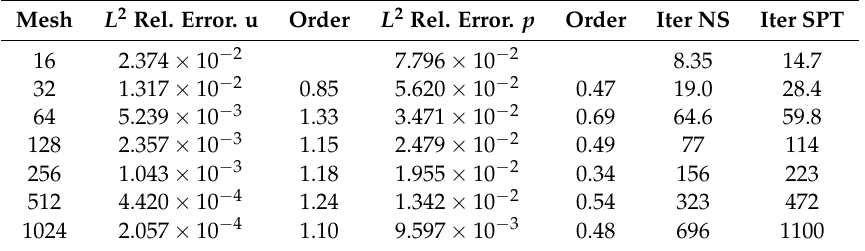
Table 2. L 2 relative errors in space and corresponding orders for the velocity and the pressure— rotational pressure-correction method with first-order approach.